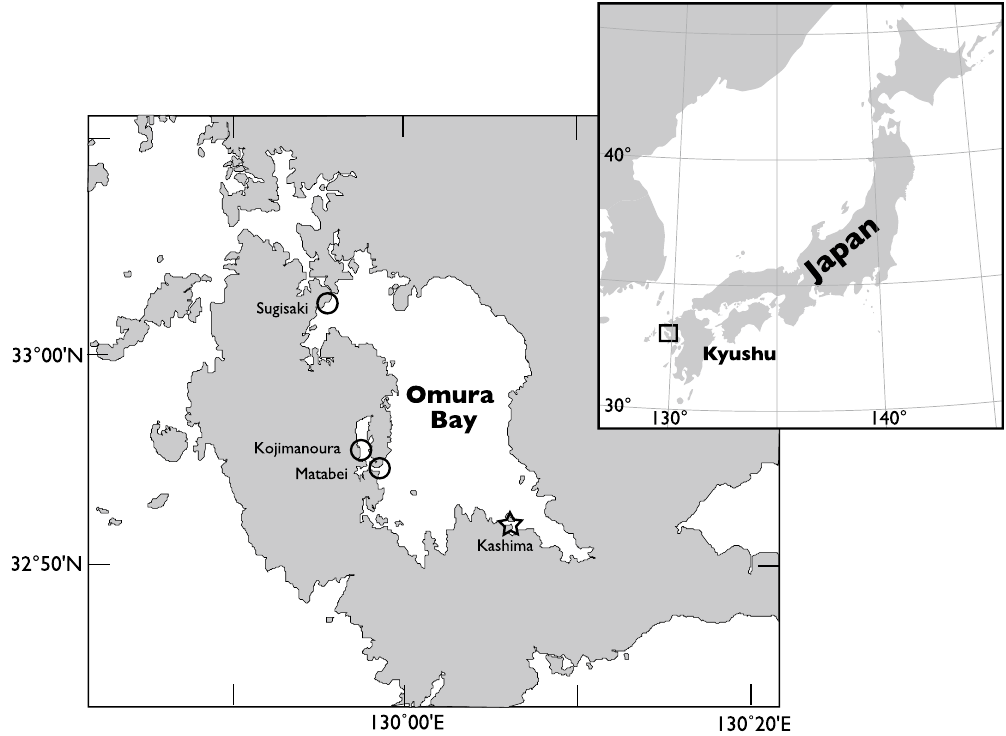
Figure 1. Map of Omura Bay, Japan with the observation sites for monitoring finless porpoise behavior. Star indicates land-based observation site, and open circles indicate aerial observation sites. Map was created using